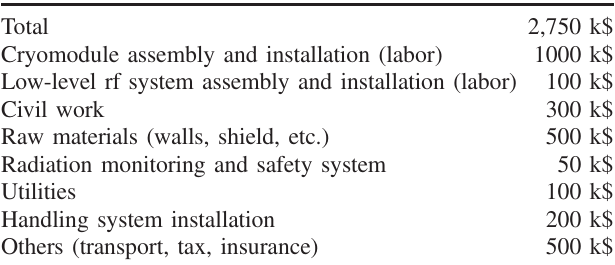
TABLE VII. Cost of infrastructure and installation.